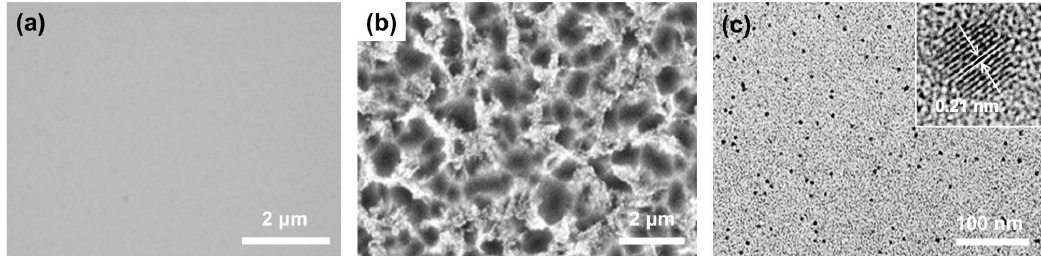
Figure 2. The field-emission scanning electron microscope (FESEM) image of ( a ) the pristine SiC plate and ( b ) the GQDs on the SiC plate after being annealed at 1500 °C on hydrogen etching gas. ( c ) The transmission electron microscope (TEM) image of the detached GQDs and the high-resolution transmission electron microscope (HRTEM) image of the GQDs with their lattice spacing.